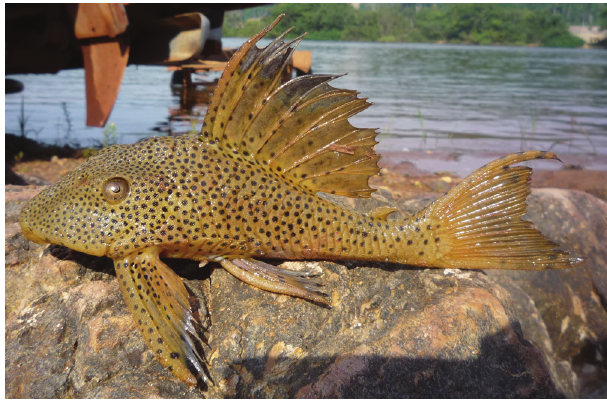
Fig. 3. Live specimen of Hypostomus dardanelos , MNRJ 36319, paratype, 145.5 mm SL, from the rio Aripuanã at the rapids downstream cachoeira Dardanelos, município de Aripuanã, Mato Grosso State, Brazil. Photographed immediately after capture by F.